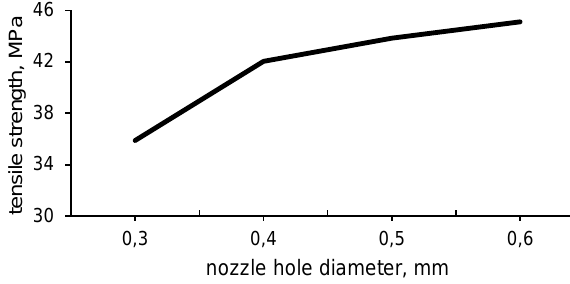
Figure 5: The graph of relation between tensile strength and nozzle